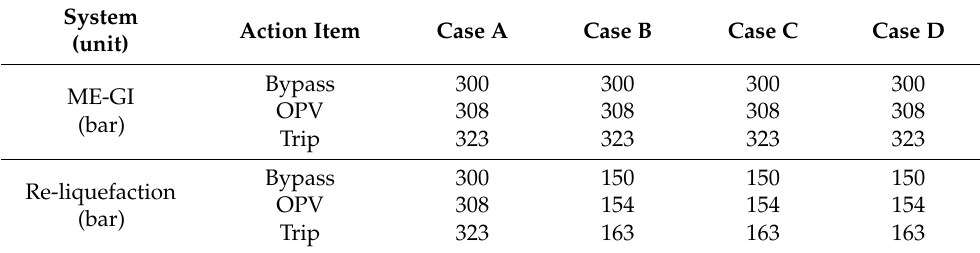
Table 4. Pressure setting values.